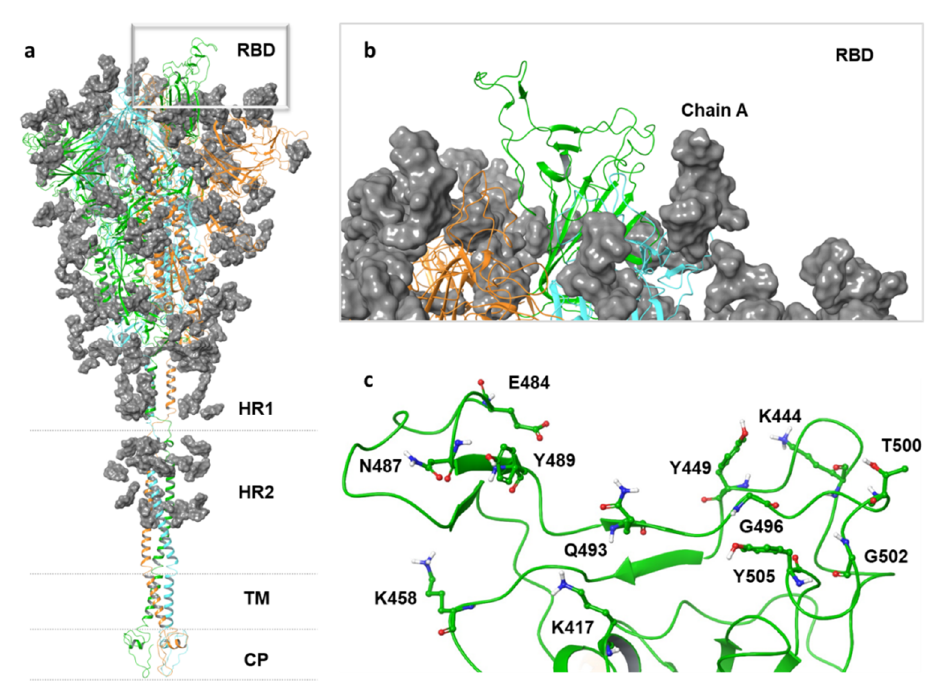
Figure 1. ( a ) A model structure of full-length SARS-CoV-2 S protein is shown in the left panel. All chains (A,B,C) are represented by a secondary structure in cartoon representation, while the gray surface represents all the glycans. ( b ) The focus on chain A is depicted with green cartoons in the top right panel. ( c ) The spike glycoprotein amino acids exposed to the surface (K417, K458, N487, Y489, Q493, G496, T500, and G502) are shown as ball and stick representations, based on atom type model, in the bottom right panel.